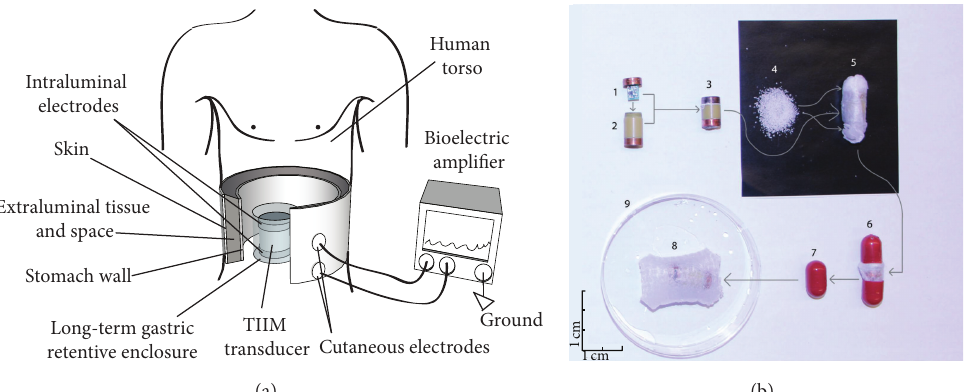
Figure 1: (a) The TIIM principle shown schematically: a small electrical signal is emitted from the TIIM transducer intraluminally from within the stomach after ingestion. The transducer is contained within an expandable pill that swells within the stomach, thus preventing it from being expelled through the pylorus for a prolonged amount of time (days). The attenuation dynamics of the electrical signal across the gastric and extraluminal tissue is measured from the skin via external cutaneous electrodes. The TIIM signals are measured using a standard multichannel bioelectric amplifier (electrogastrograph). After a predetermined amount of time (depending on the materials used), the long-term gastric-retentive enclosure disintegrates and the resulting smaller constituents of the pill individually exit the gastrointestinal tract via natural peristalsis. The TIIM components in the figure are deliberately zoomed in. (b) TIIM gastric-retentive pill design: (1) electronic oscillator circuit; (2) capsule body; (3) assembled capsule; (4) superabsorbent granules; (5) capsule and granules inside a liquid-permeable mesh;(6)dissolvablepillcontainingthemeshedcapsule;(7)TIIMgastric-retentivepill;(8)pillexpandedinwater;and(9)testdish.Horizontal and vertical 1cm scales are depicted at the bottom left